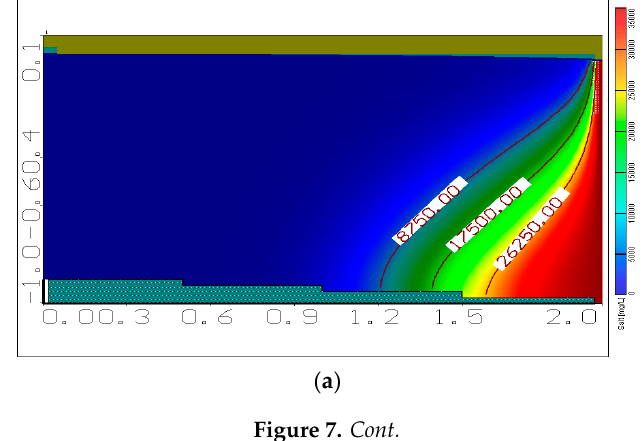
Figure 6. Schematic sketch of bed slopes of 20:1 and 10:1 toward the land.